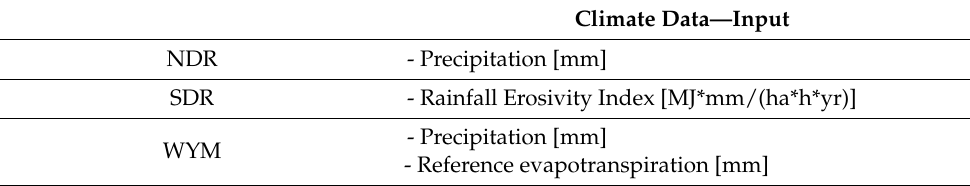
Table 4. Input climate data used in our InVEST